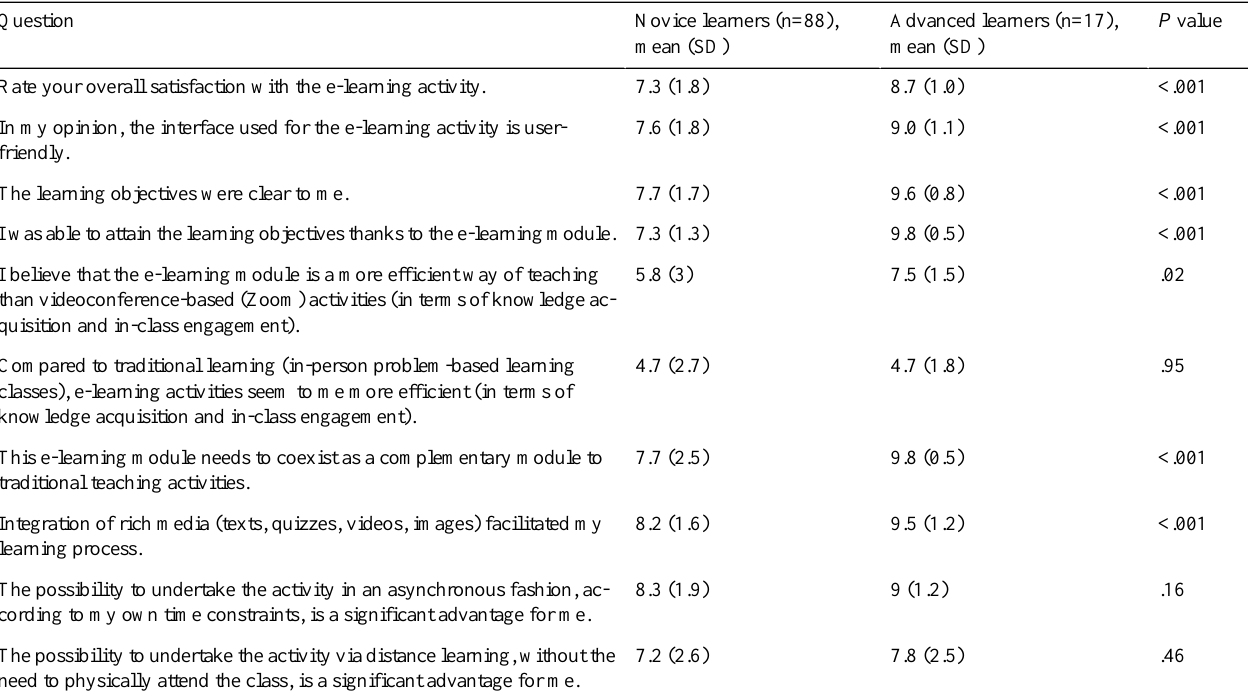
P valueAdvanced learners (n=17),